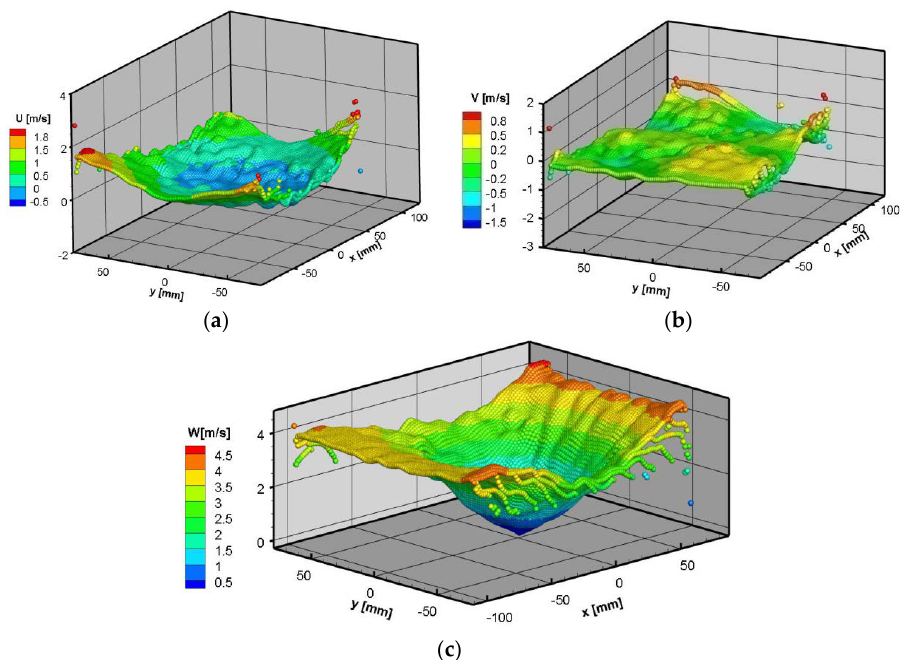
Figure 3. Measured time averaged velocities by HSS PIV in 1.4 s: ( a ) axial ( U ), ( b ) radial ( V ), and ( c ) circumferential ( W ) [14].